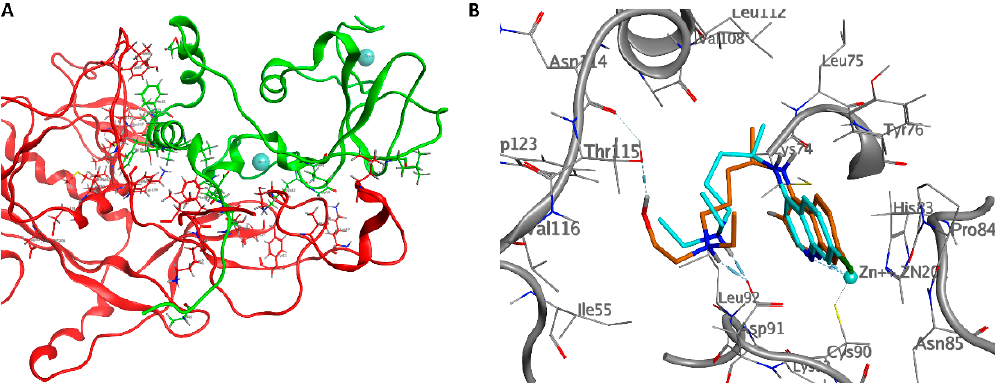
Figure 4. ( A ) Intermolecular interactions between nsp14 (red) is stabilized by nsp10 (green). Zinc ions are represented as blue spheres. ( B ) Docked poses of CQ (blue) and HCQ (orange) are shown with the residues of the binding pocket and the residues interacting with the nsp10 cavity.